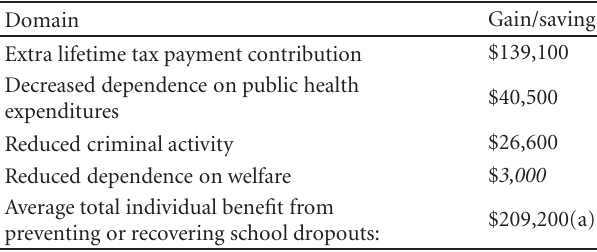
Table 1: Average societal (USA) benefits or cost reductions per student attributable to graduating versus not-graduating from high school, by benefit or cost domain